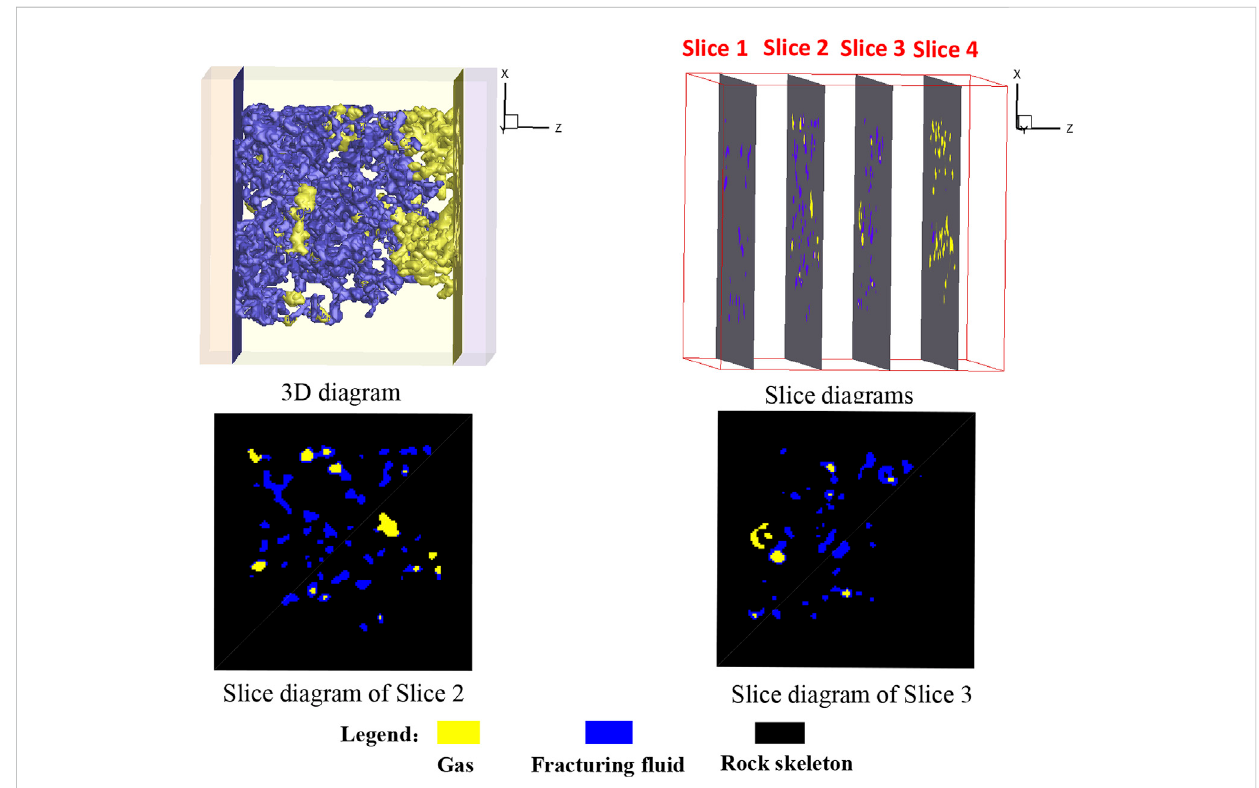
FIGURE 6 Slice diagrams of gas-liquid distribution at the equilibrium state ( t (cid:2) 6 . 0 × 10 6 ) in the imbibition process.